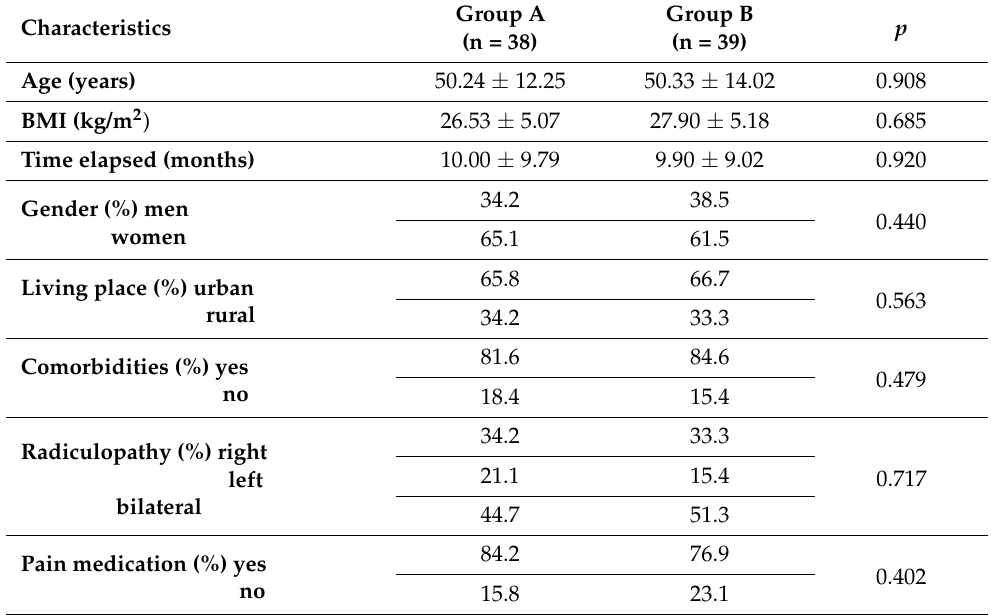
Table 1. Demographic characteristics (mean ± SD/%), time overdue between diagnosis and treatment (mean ± SD), and radiculopathy (%) (n =